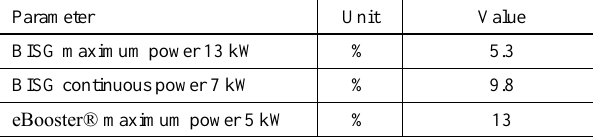
Table 4. SS time percentage at which BISG or eBooster® can be used Parameter Unit Value BISG maximum power 13 kW